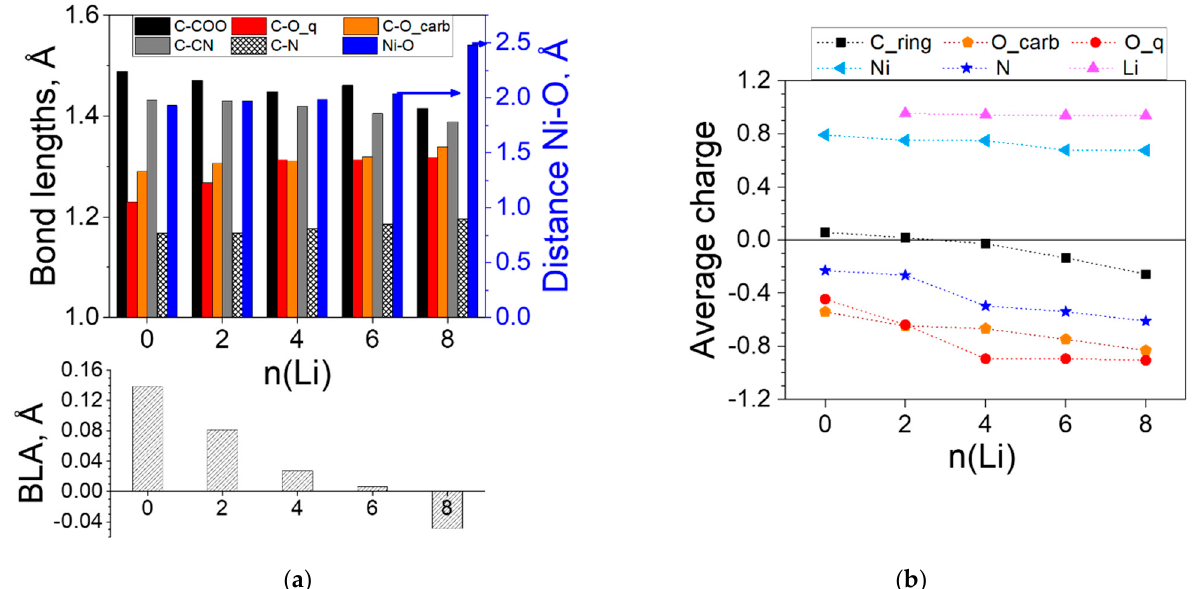
Figure 3. Ni(II)(L1) 2 complex: ( a ) variation in the averaged bond lengths (Ni-O on the right axis) and bond length alternation (BLA); ( b ) averaged charges upon introduction of n Li atoms. Numerical values can be found in Tables S2 and S3.